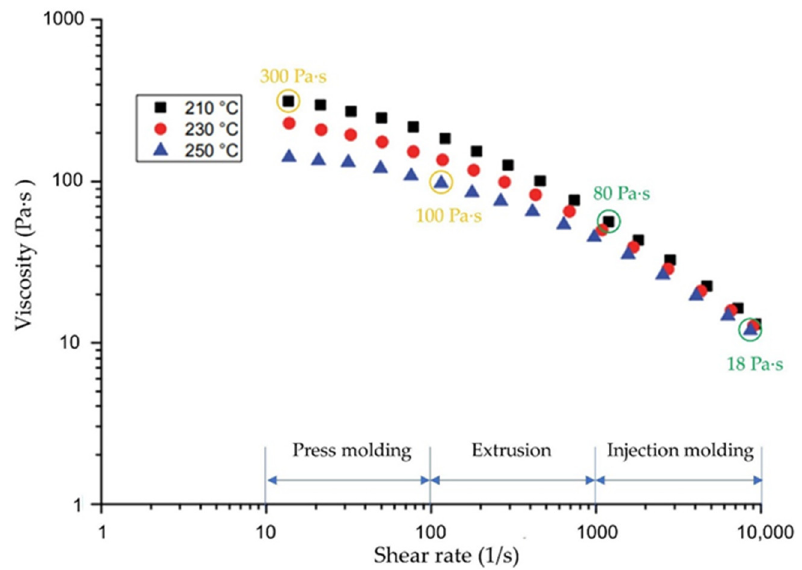
Figure 1. Temperature and shear rate dependent rheological behavior of PP in relation to typical manufacturing processes for fiber-reinforced composites (press molding, extrusion and injection molding) in accordance with [22].